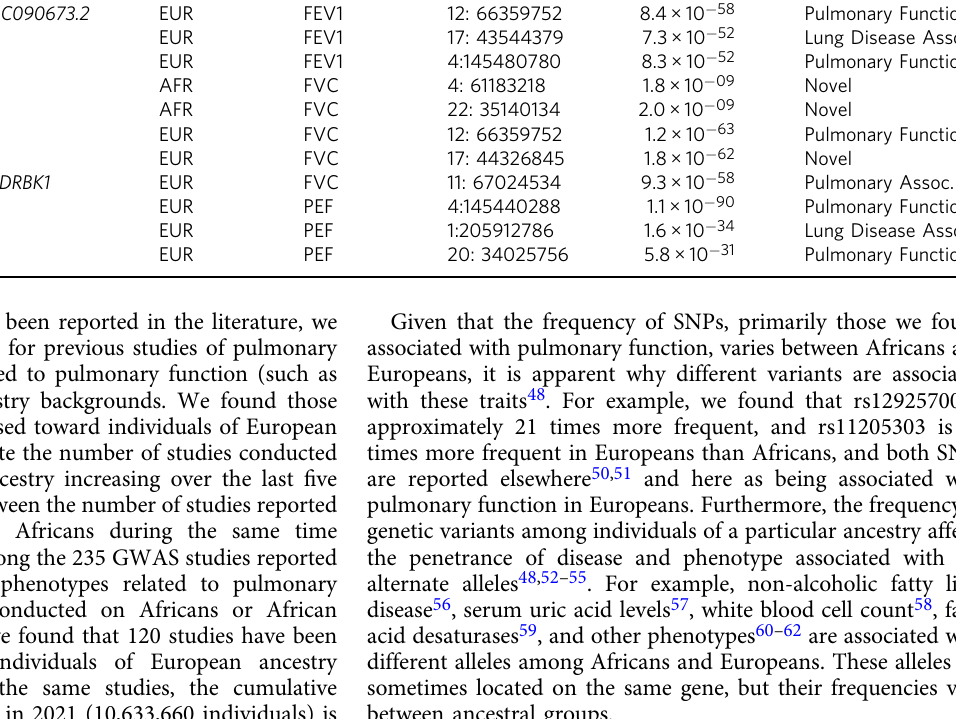
Table 2 Top signi fi cant variants associated with pulmonary function.